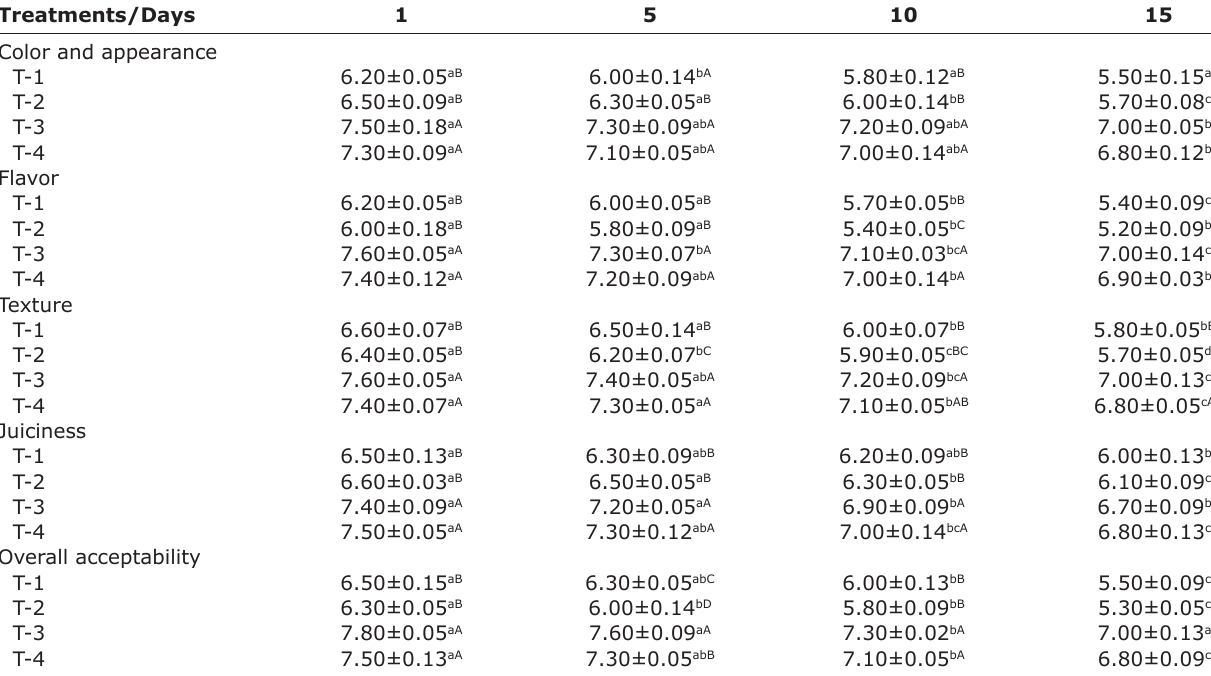
Table-5: Sensory properties of Vawksa rep (smoked pork product) stored under vacuum packaging conditions at 4°C±1°C. Treatments/Days